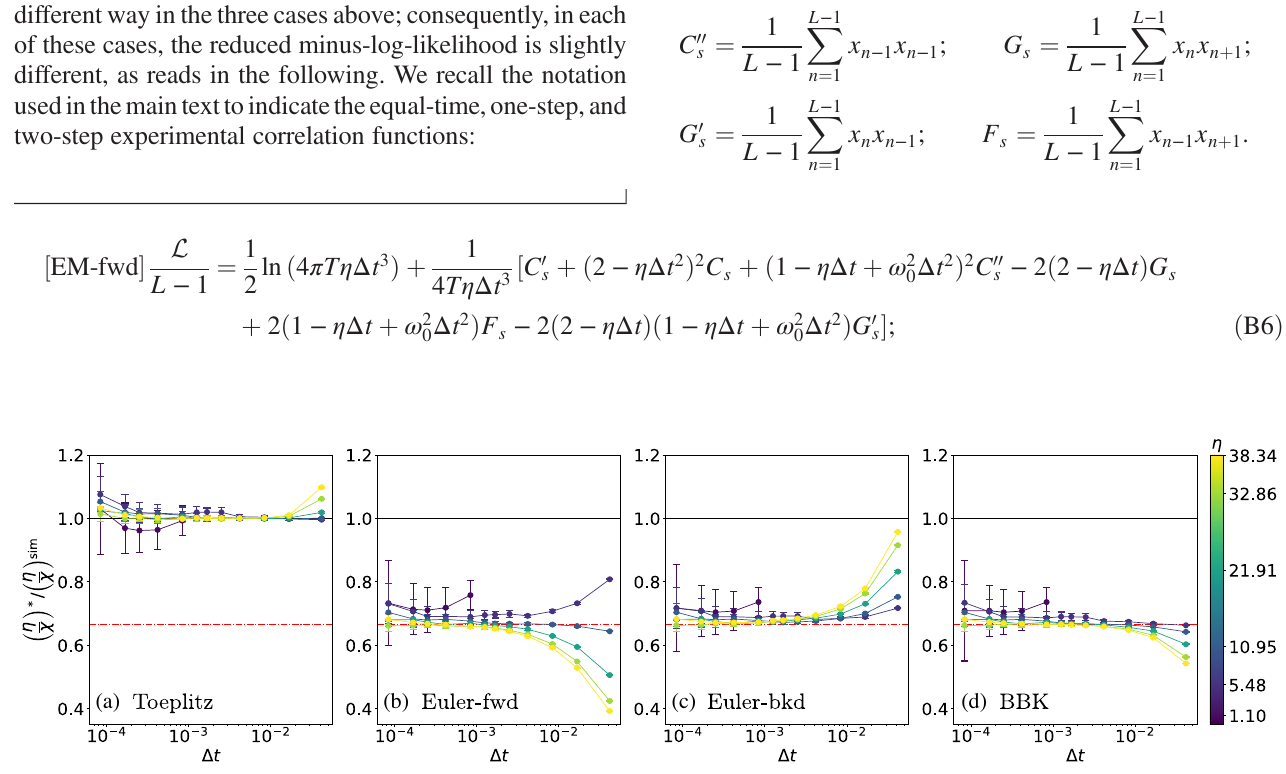
FIG. 8. Accuracy of the different likelihood-based methods in inferring the effective parameter η = χ of the inertial spin model: (a) shows the O ð Δ t 3 = 2 Þ Toeplitz method; (b) – (d) show the three O ð Δ t 1 = 2 Þ variants corresponding, respectively, to the Euler-forward, Euler-backward, and BBK schemes. We see the 2 = 3 factor for the O ð Δ t 1 = 2 Þ schemes (red dot-dashed line) and no rescaling for the O ð Δ t 3 = 2 Þ scheme. ISM simulations are performed in different damping regimes: The sampled values for the parameter η sim are indicated 6 , and N ¼ 1000 . Each point is the average of the along the color bar. The remaining parameters are χ ¼ 1 , T ¼ 0 . 4 , J ¼ 5 . 0 , n c ¼ inference results of ten different trajectories of 200 points (for any Δ t ). Error bars correspond to 0.95